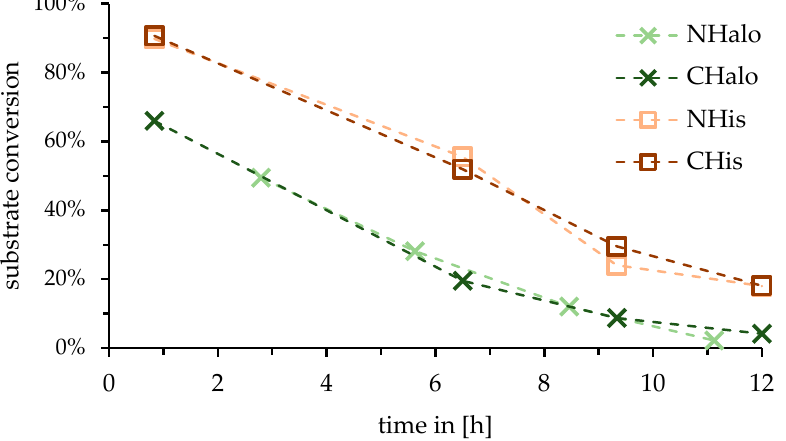
Figure 2. Change in substrate conversion over time by continuous usage for the reaction of hexanal ( 1 ) and acetaldehyde ( 2 ) towards 3-hydroxyoctanal ( 3 ) catalyzed via the DERA reactors. (Hexanal ( 1 ) as observed substrate.) Light-green cross: reactor with N-terminal HaloTag ® -DERA (NHalo). Dark-green cross: reactor with C-terminal HaloTag ® -DERA (CHalo). Light-brown square: reactor with N-terminal HisTag-DERA (NHis). Dark-brown square: reactor with C-terminal HisTag-DERA (CHis). Outliers are not shown (compare Supplementary Figure S3).